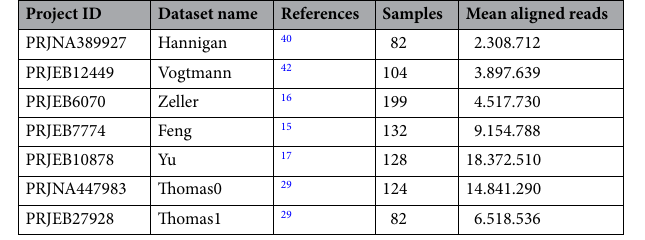
Table 1. Datasets used in the